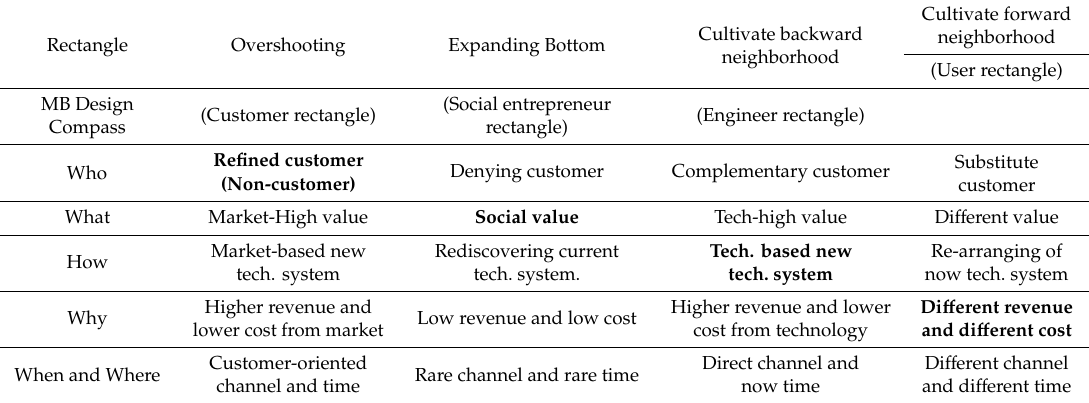
Table 2. Diverse matches between rectangular compass and business model design